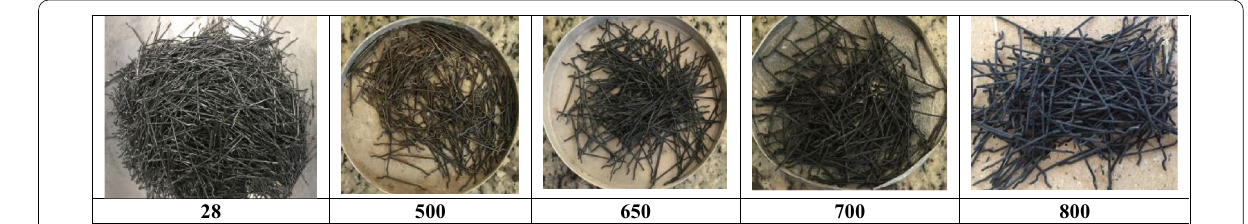
Fig. 1 Changes in the shape of steel fibers exposed to high